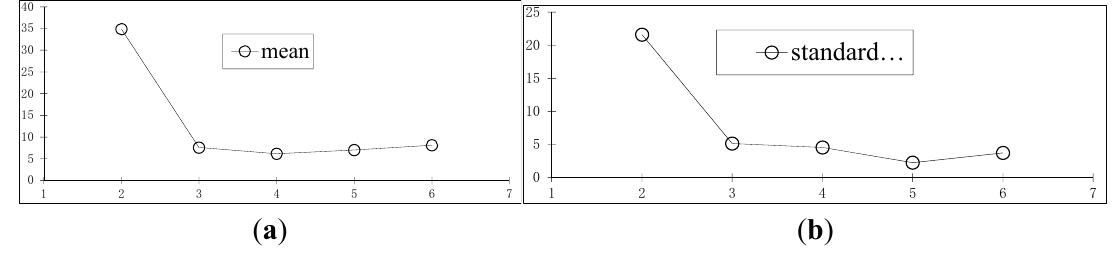
Figure 7. The rebuilding errors of the polynomials with the different orders. ( a ) The curve for mean values of residuals; ( b ) The standard deviation curve of